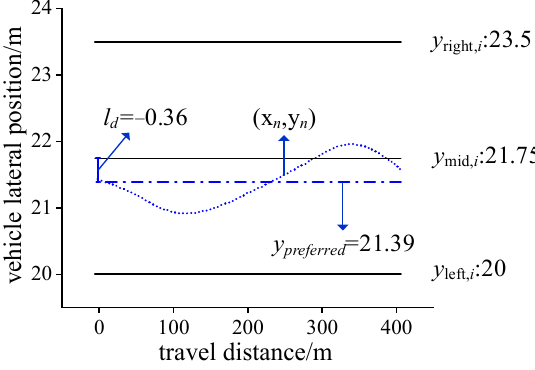
Figure 5. Example of calculation of feature parameters.